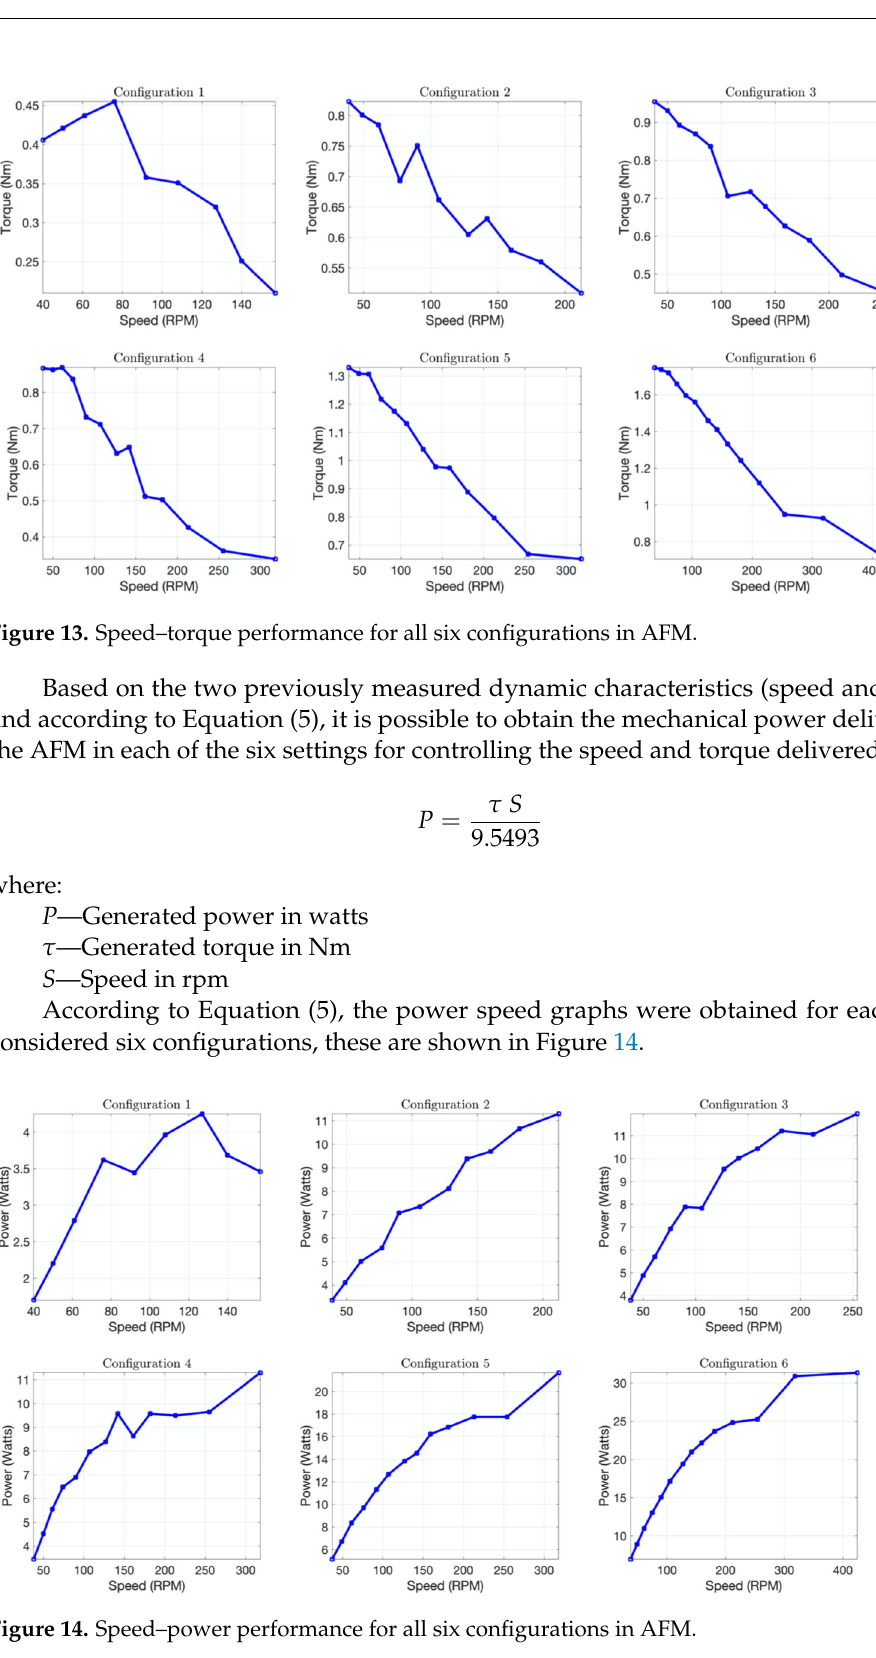
Figure 12. Behavior speed–frequency.